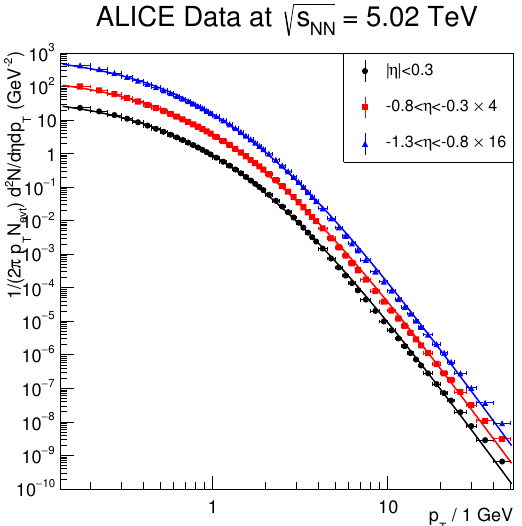
Figure 5. Fit of inclusive double-di(cid:11)erential charged hadron production cross sections obtained in proton-lead collisions at center of mass energy p s = 5.02 by the ALICE Collaboration, presented in [95]. Two of the datasets are rescaled by factors of four and sixteen for visual clarity. The data are displayed alongside (cid:12)ts to the model in eq.